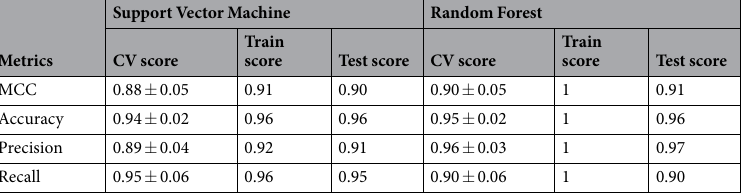
Table 1. Performance of support vector machine and random forest models for ACP prediction. Scores obtained from ten-fold cross-validation (CV) score ( mean ± std ), on the whole training dataset (Train score) and the independent test dataset (Test score) for the support vector machine and random forest models.